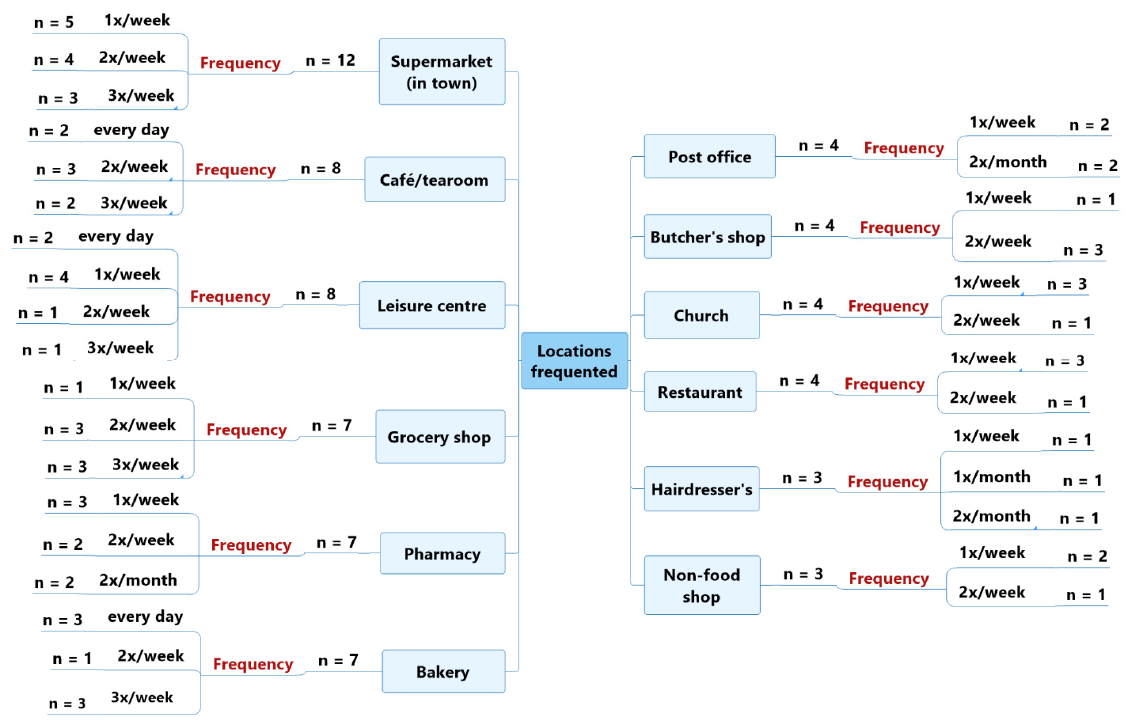
Figure 1. Characteristics of the locations frequented by the participants without self-reported cognitive impairments.